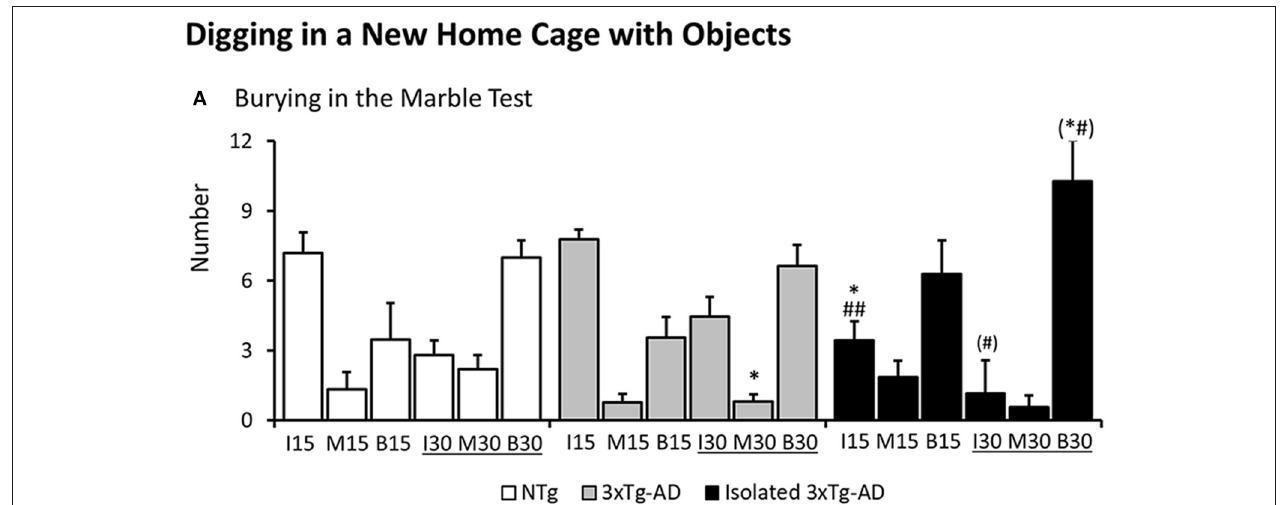
FIGURE 3 | Digging in a new home cage with small objects (Marble test). Results are expressed as mean ± SEM (A) At 15 and 30min of the test, the number of marbles left intact (I15, I30), half-buried or moved (M15, M30) or completely buried (B15, B30) is indicated. Statistics: One-way ANOVA followed by post-hoc Duncan’s test, * p < 0.05, ** p < 0.01, and *** p < 0.001 vs. the NTg mice; # p < 0.05. vs. the 3xTg-AD